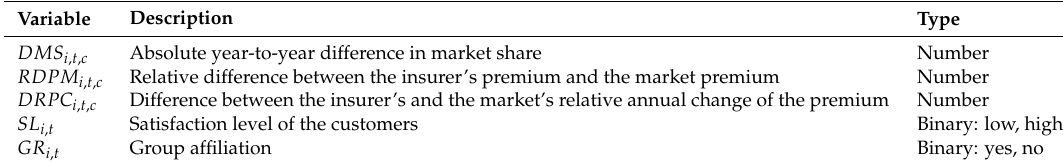
Table 3. Description of the